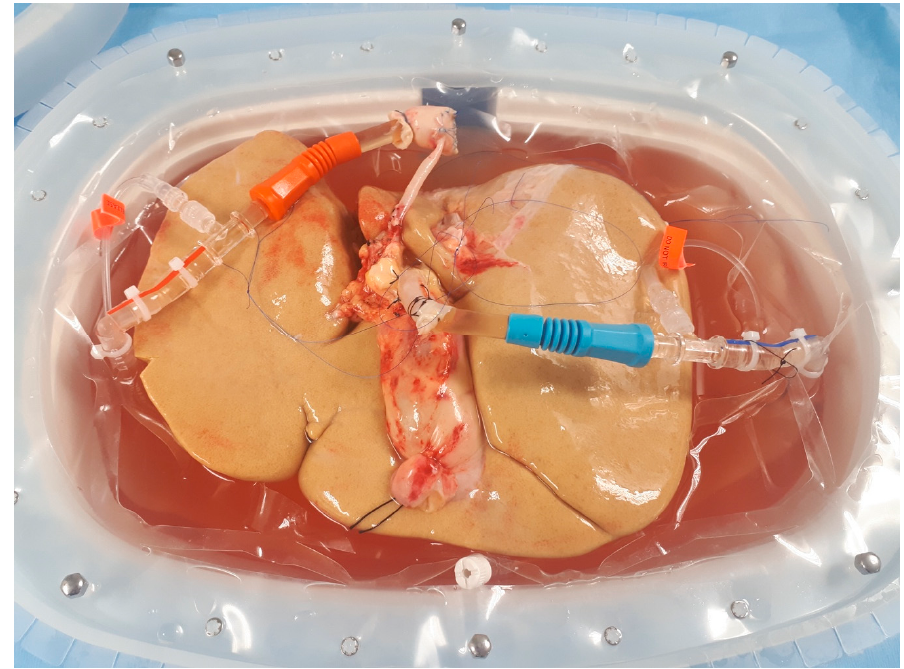
Figure 1. Liver allograft with extensive steatosis undergoing hypothermic oxygenated machine perfusion. Image from the authors’ department. perfusion. Image from the authors’